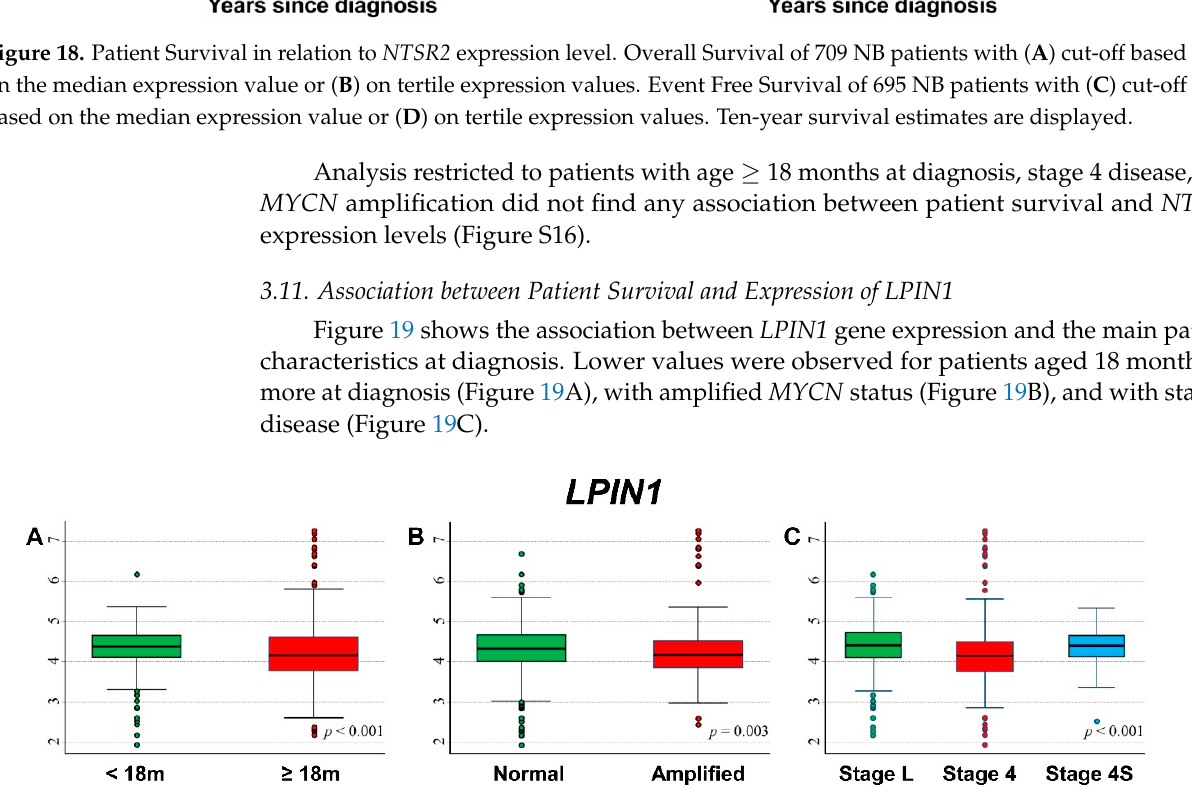
N/E = Number of patients/Events HR: Hazard Ratio. Multivariable analysis: HRs are adjusted by MYCN status, age, and stage at diagnosis. Figure 18. Patient Survival in relation to NTSR2 expression level. Overall Survival of 709 NB patients with ( A ) cut ‐ off based on the median expression value or ( B ) on tertile expression values. Event Free Survival of 695 NB patients with ( C ) cut ‐ off based on the median expression value or ( D ) on tertile expression values. Ten ‐ year survival estimates are displayed.